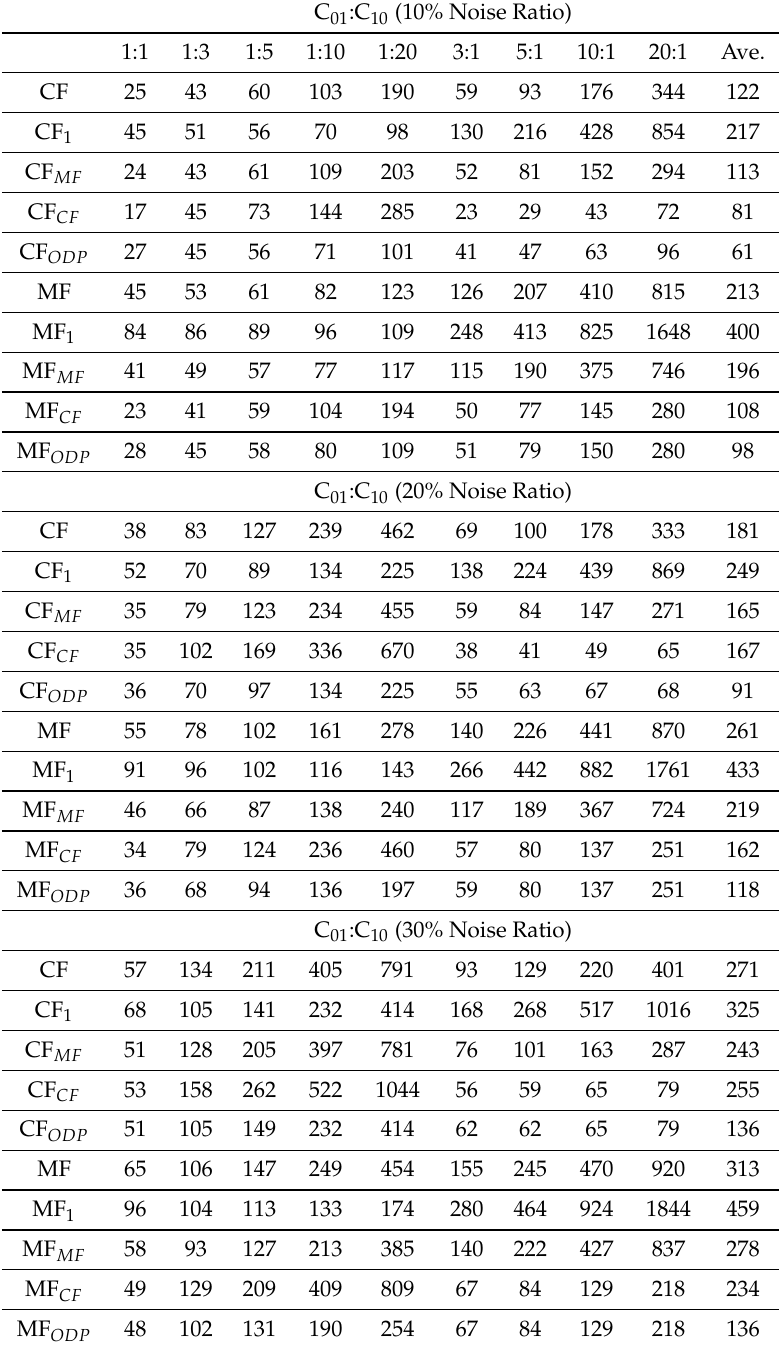
Table 13. Cost comparisons on Spect1 in the case that the noise ratio and noise-free dataset are